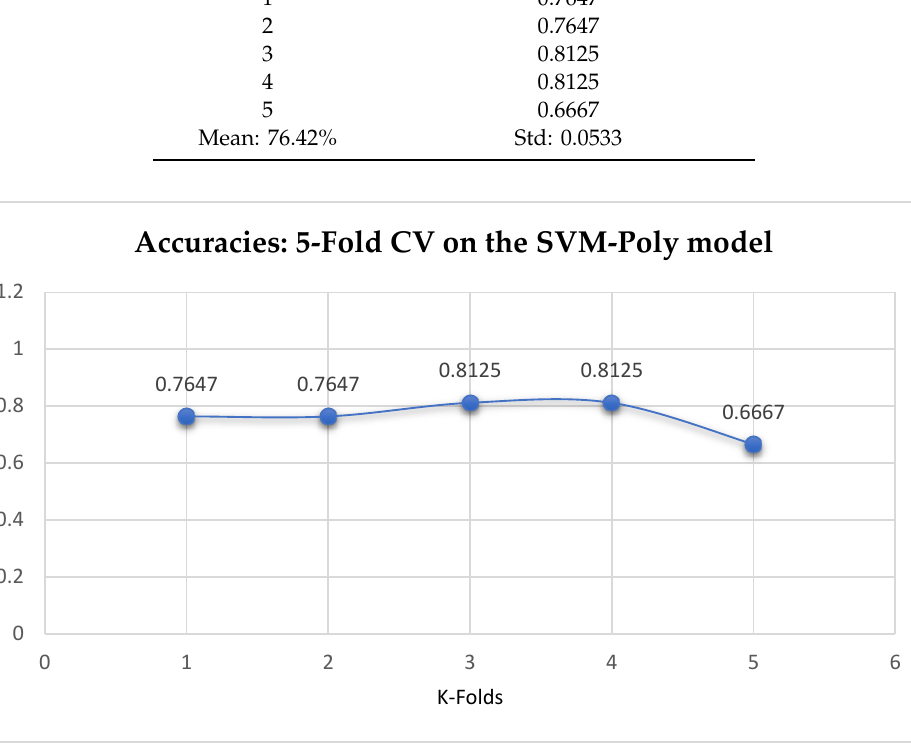
Figure 29. The accuracies achieved by the Folds after performing 5-Fold Cross-Validation on the SVM-Poly model.